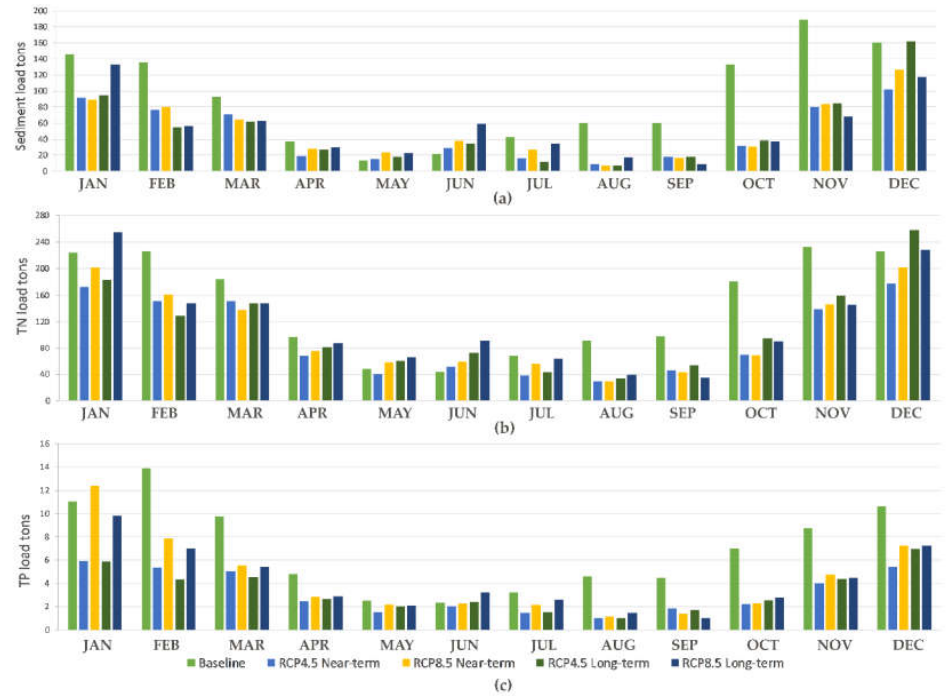
Figure 9. Predicted ( a ) sediment; ( b ) total phosphorus; ( c ) total nitrogen load for every month under RCP 4.5 and RCP 8.5 of the Minija River watershed for near-term and long-term periods, compared with the baseline